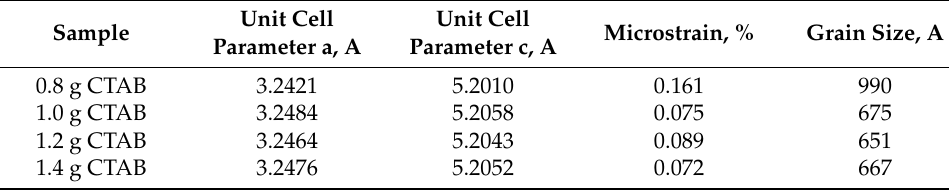
Figure 1. XRD patterns of the as-prepared ZnO synthesized with different quantities of CTAB. Table 1. Crystal structure parameters of all samples calculated from XRD data.